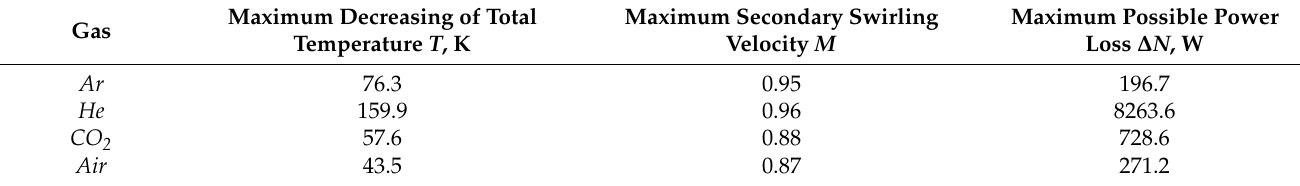
Figure 22. Vector velocity distribution obtained for SVT with: ( a ) Ar ; ( b ) air ; ( c ) He ; and ( d ) CO 2 . Despite the similar values of projected velocities, the absence of the inner body led to an increase in SVT performance, as shown in Table 11. The resulting cooling performance for SVT with Ar , helium, carbon dioxide, and air increased by 11.7 K, 28.7 K, 1.5 K, and 2.8 K, respectively. Table 11. SVT efficiency with the same Reynolds number and without the inner body.